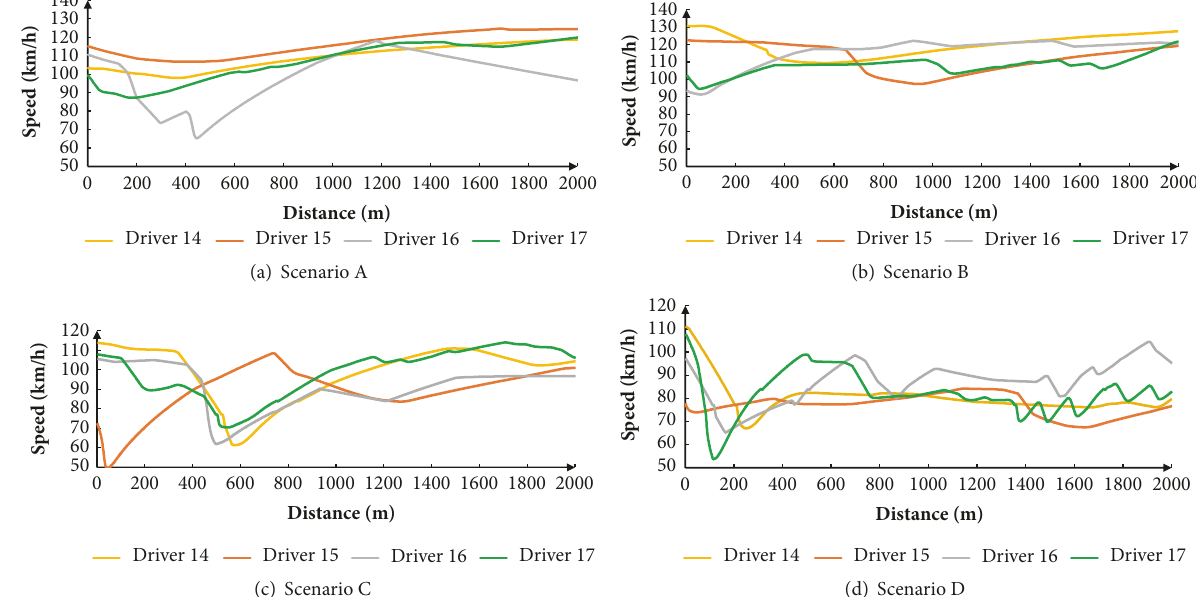
Figure 7: Impact of the OBU and traffic condition on speed profile of drivers 14-17.